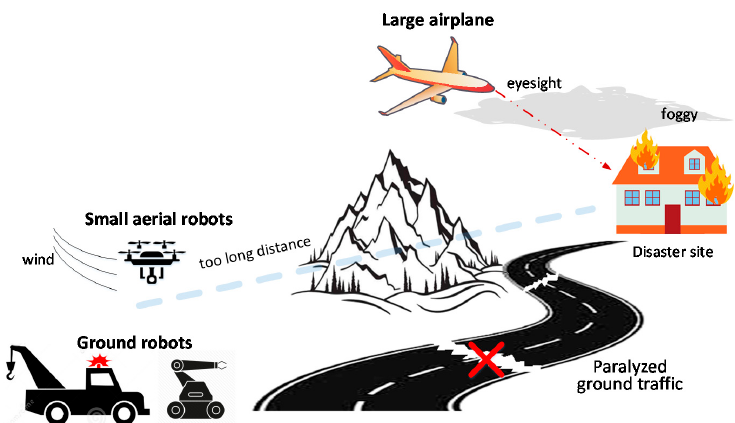
Figure 1. Limitations of traditional sensing modes under paralyzed ground traffic situations.